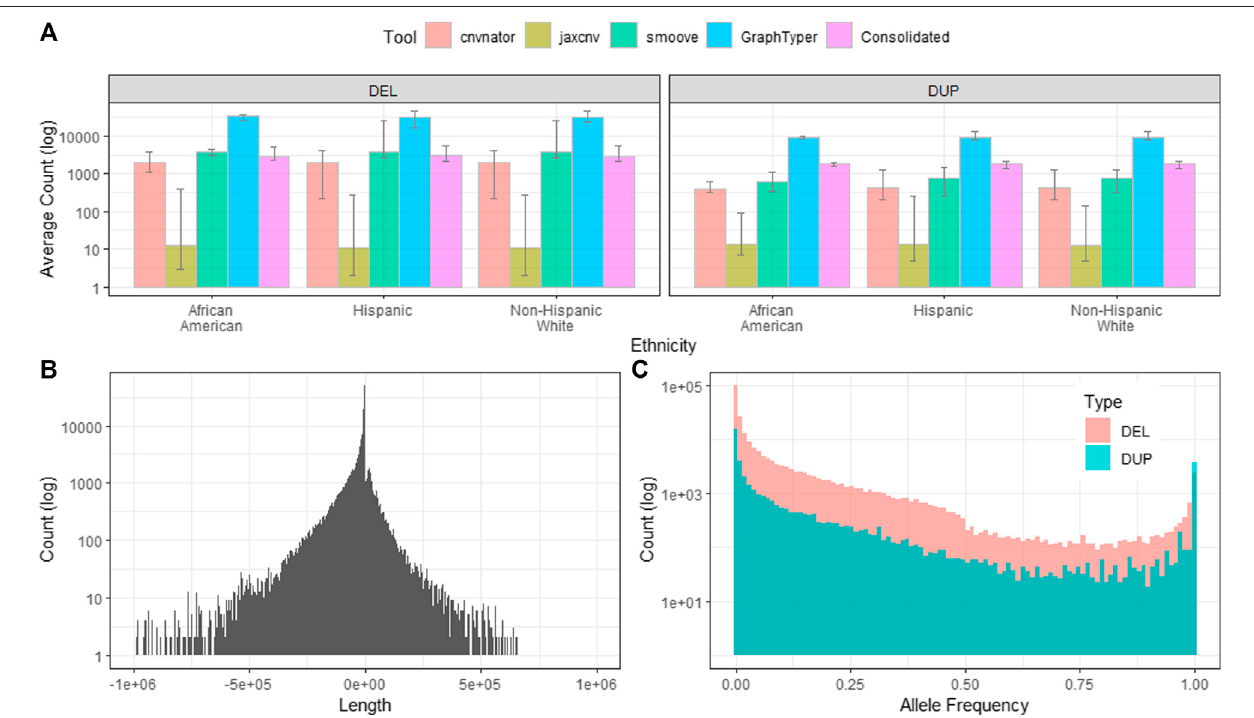
FIGURE 3 | Characteristics of the project level CNV callset. Counts shown on the y -axes of the sub fi gures are in the log10 scale. (A). The average deletions and duplications detected by CNVnator, JAX-CNV, Smoove and GraphTyper2. Consolidated shows CNV counts after CNV merging and con fl icts removing. (B). Length distributionofCNVsafterapplyingGraphTyper2andthePASS fl ag fi lter.Lengthsofdeletionswerepresentedasnegativevalueswhilelengthsofduplicationsarepositive values. (C). Allele frequency of CNVs of